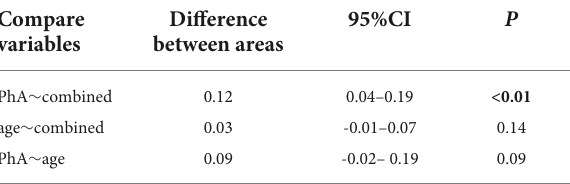
TABLE 3 Comparison of the AUROC of the three diagnostic indicators for all patients. Compare Difference 95%CI P variables between areas PhA ∼ combined 0.12 0.04–0.19 <0.01